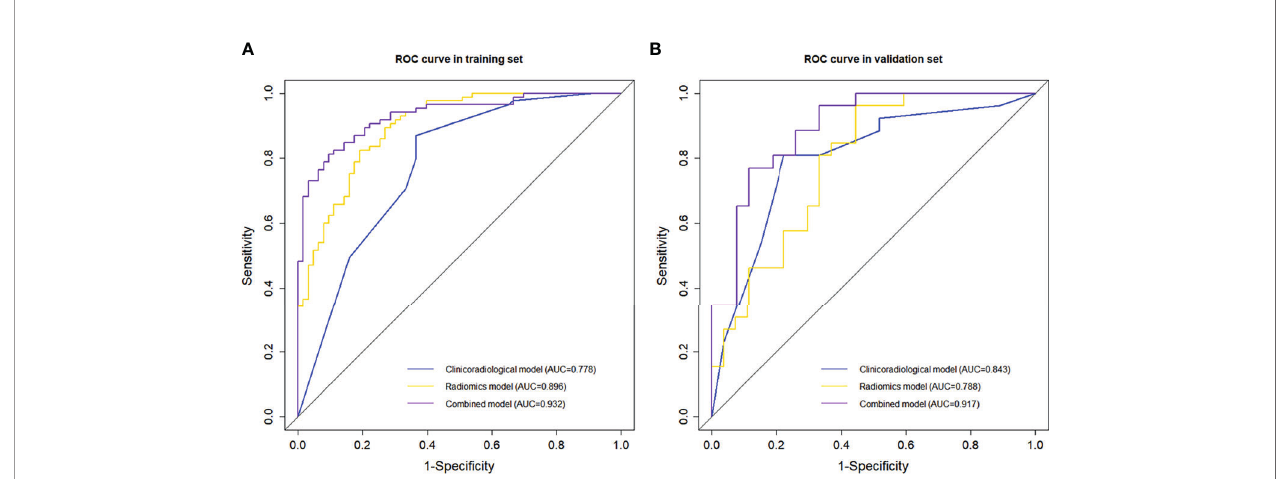
FIGURE 2 | Comparison of receiver operating characteristic (ROC) curves in predicting MVI presence. ROC curves of the clinicoradiological model, radiomics model and the combined model in the (A) training and (B) validation sets.